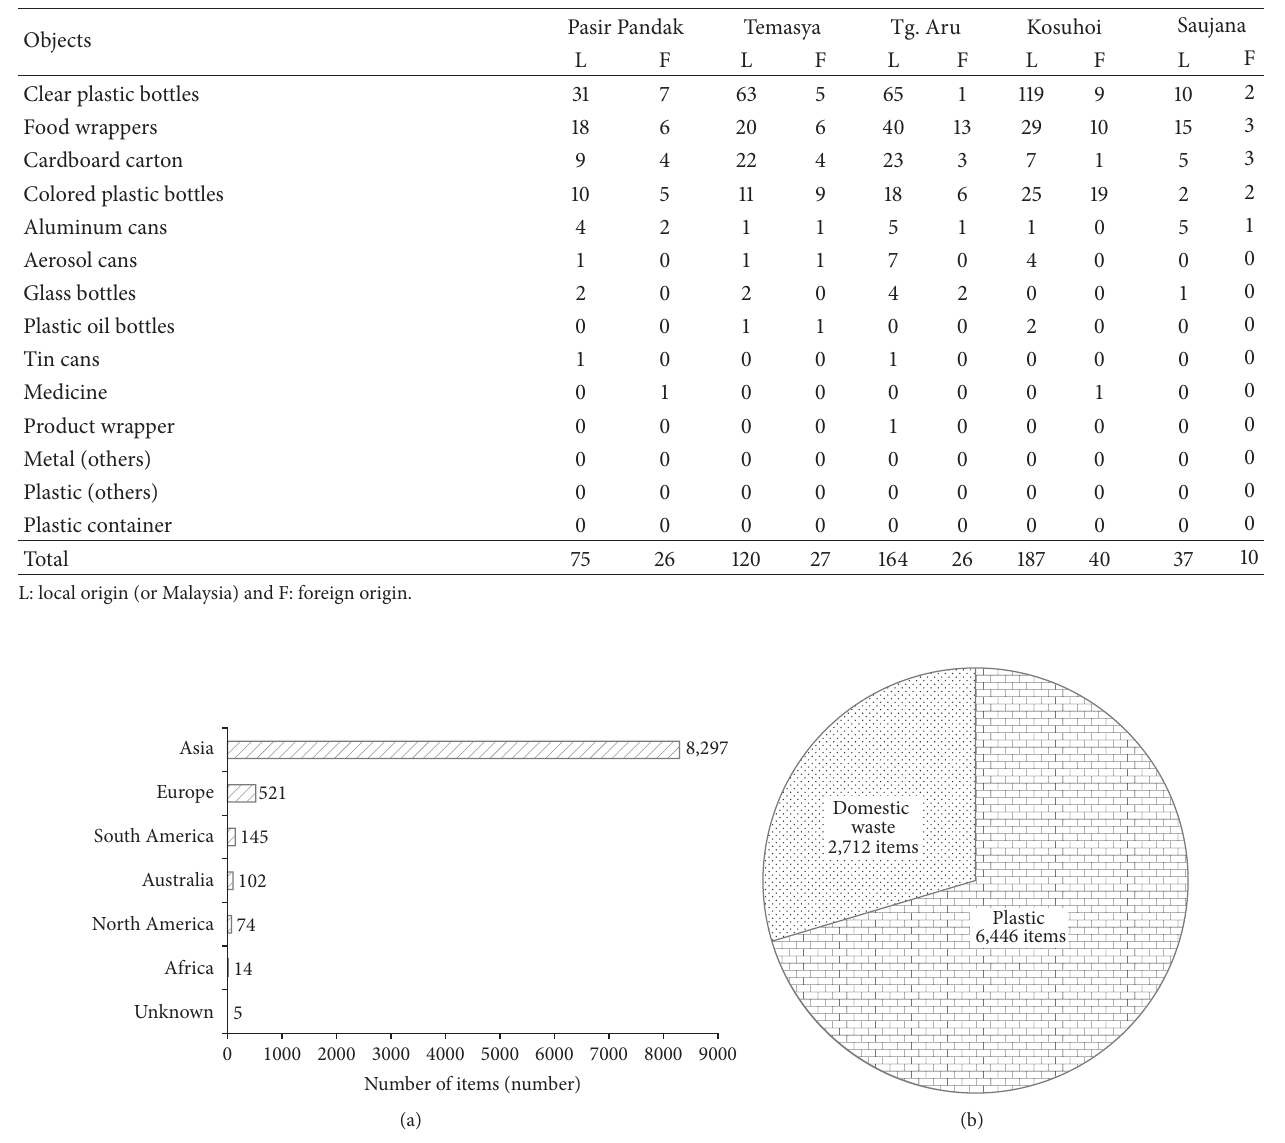
Arc Waste Destruction System, and manual trash compactor which can process all types of waste generated on